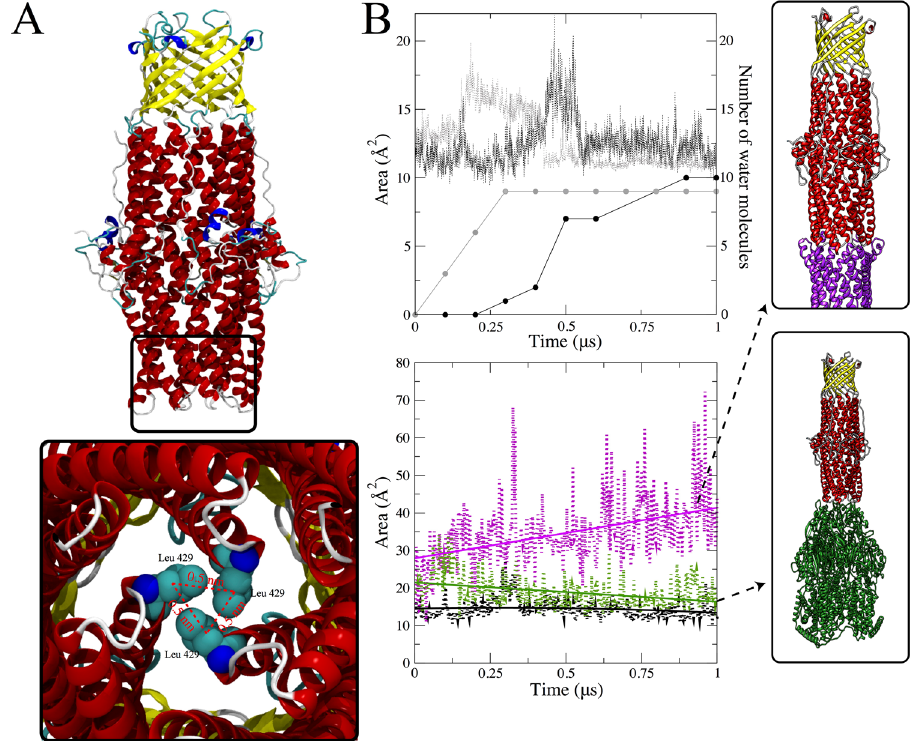
Figure 4. MexA-dependent opening of the OprM periplasmic aperture. ( A ) Structure of OprM highlighting the constraints in the periplasmic tips. Three helices are packed together and enclose three hydrophobic leucine residues (Leu429; one per OprM protomer) with an α -carbon distance value of 0.5 nm between each pair of leucines. These three leucine residues are used as reference points for computing a triangular-shaped area (dotted red lines) for monitoring the aperture area. ( B ) Top panel: Spontaneous partial opening that leads to water translocation through the closed state of OprM. Two independent simulations (black and grey dotted lines) reveal stochastic partial opening with an increase of ~5 Å 2 that allows the permeation of 10 water molecules. This process occurs within 1 µ s of the simulation (black and grey dotted lines). Bottom panel: OprM aperture opening is activated by the close interactions between the outer membrane and periplasmic proteins (purple). The aperture opening was computed as a function of the enclosed triangular shaped area as given in ( A ). As a reference, the average area of closed OprM (black) is also provided. Aperture opening of OprM is not fully triggered by the interaction with the inner component MexB (green) and remains only in a partially opened